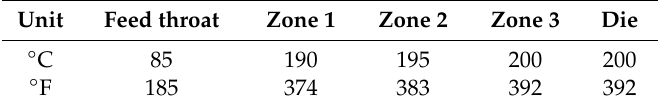
Table 2. Temperature